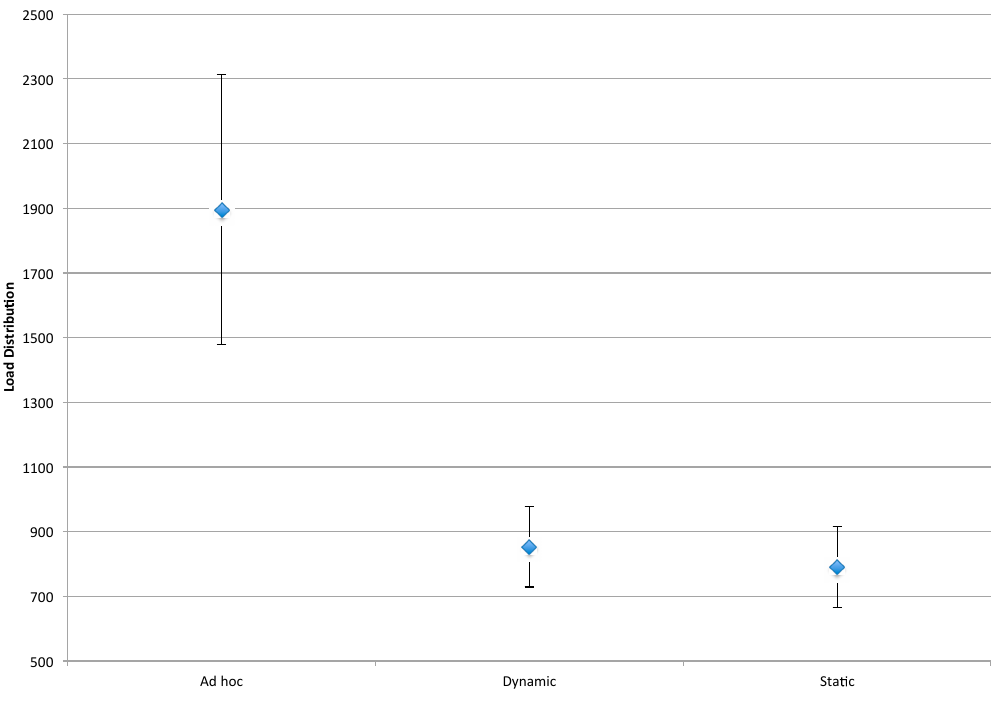
Figure 7. Interval plot for load distribution. n = 160, ANOVA, 1 df , p < 0.05.